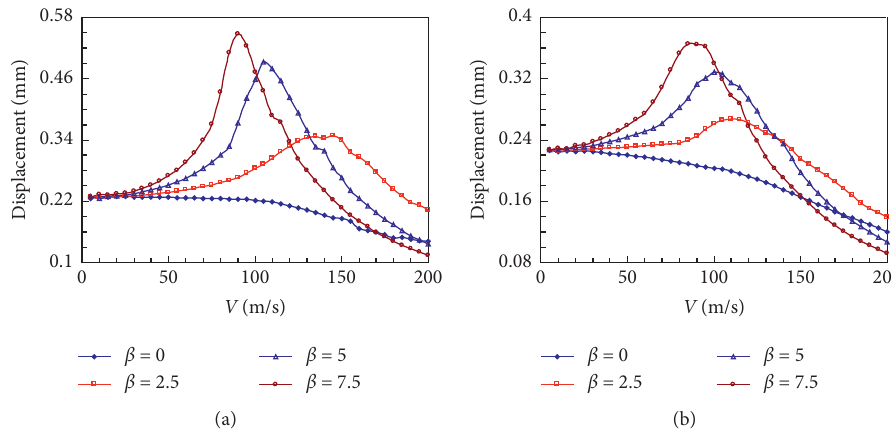
Figure 10: The maximum displacements of the track with various viscous damping: (a) c � 5 × 10 5 Ns/m 2 and (b) c � 1 × 10 6 Ns/m 2 .